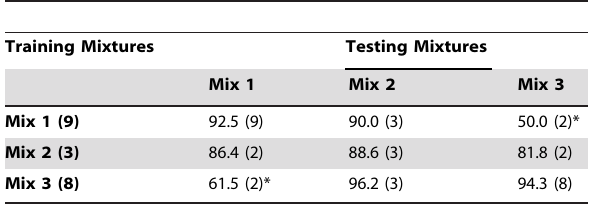
Table 4. Maximum PER Response [%] to Odorants Relative to Occurrence in Mixtures.